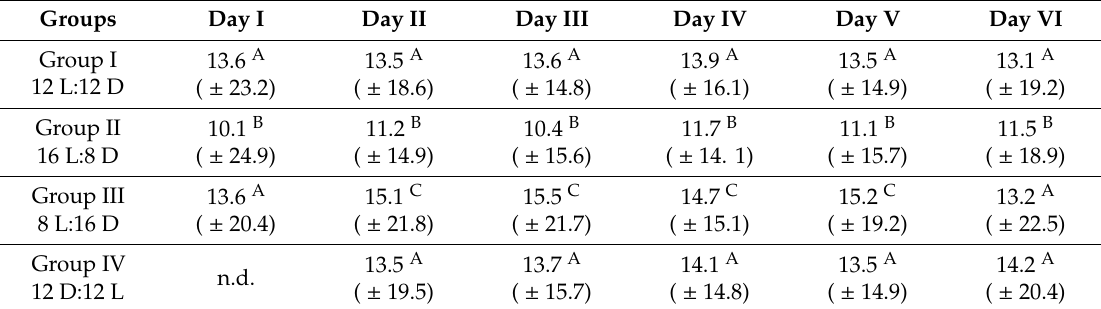
Figure 4. Experiment II. Secretion of MLT (mean) from turkey pineal organs incubated under a 12 L:12 D cycle (group I), a 8 L:16 D cycle (group II) and a 16 L:8 D cycle (group III) during four consecutive days and then in continuous darkness. Table 2. Duration of increased MLT secretion during the scotophase or subjective night (mean, time clock presented in the format “hh.mm”; the standard error in minutes). The values labeled with di ff erent letters di ff er significantly (between groups) by the Duncan test ( p ≤ 0.05). n.d.—not